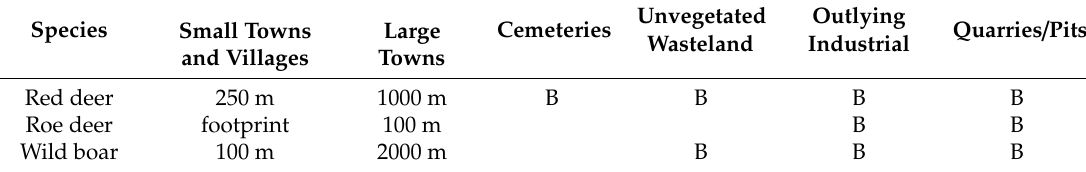
Table 2. Land cover types considered as barriers (B) to wildlife movement and rules of bu ff ering the footprint of human land use to express wildlife avoidance of anthropogenic structures. The bu ff ering rules were based on expert opinion obtained through a questionnaire distributed among wildlife biologists and forest service experts familiar with the investigated